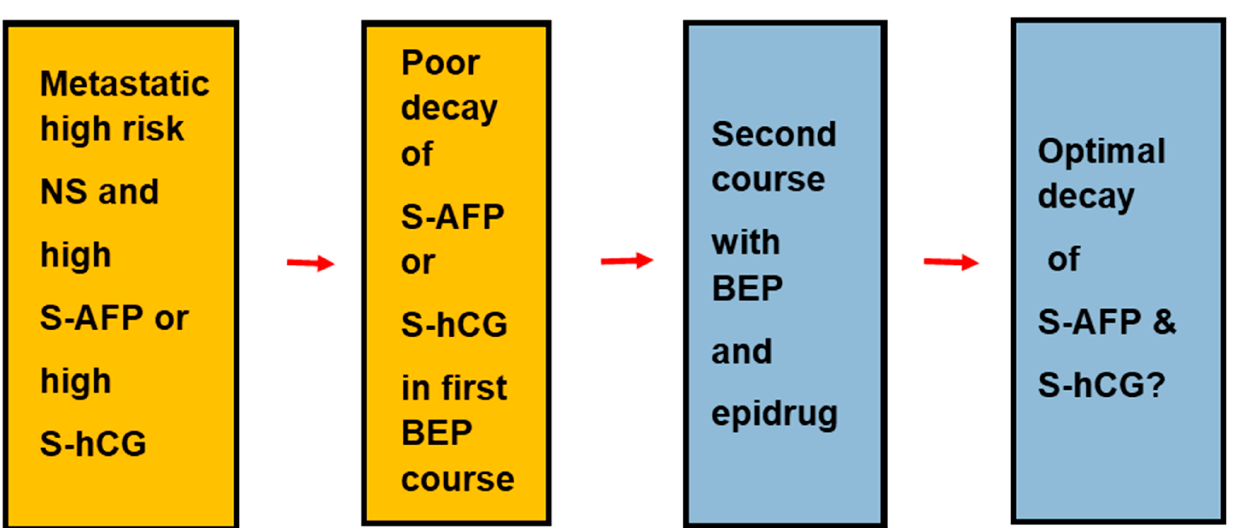
Figure 4. A new trial of epidrugs in TGCT. Candidate patients are patients with high-risk NS metastatic TGCT with insufficient decay of serum tumor markers after the first course of BEP chemotherapy. The proposed trial investigates whether combination of epidrugs and BEP chemotherapy might give response equal to high-dose salvage chemotherapy. The new elements in the trial are shown in grey boxes. If a patient fails to present with sufficient decay of two serum tumor markers, the patient will be switched to a routine high-dose cisplatin salvage chemotherapy.